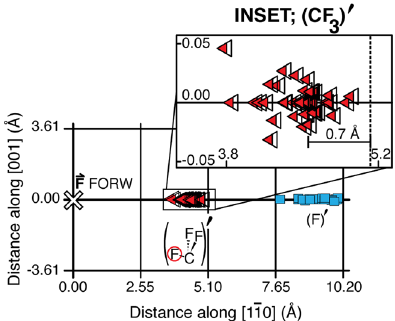
Fig. 3 Product distribution, (CF 3 ) ′ and (F) ′ , from knock-on reaction with umbrella inversion. Final positions of the products of reaction, following collision of the reagent F-atom with the adjacent CF 3 target. The reagent F- atom was formed by electron-induced dissociation of a CF 3 precursor. The two reaction products are chemisorbed (CF 3 ) ′ shown as red-tipped triangles, and (F) ′ product shown as blue squares. A schematic of the inverted (CF 3 ) ′ with the F-atom circled in red is shown below in the fi gure. The scale corresponds to the unit-cell dimensions of the Cu(110) surface. An enlarged view of the distribution of the (CF 3 ) ′ products is shown in the inset. The lateral spread in the inset is < ± 2 % of the distance between the rows. The location of the CF 3 target is marked by a dashed line. The (F) ′ product (blue squares) is found on the copper row, along with the continuation of the ‘ forward ’ direction of the incoming F-atom marked ! ‘ F FORW ’ .